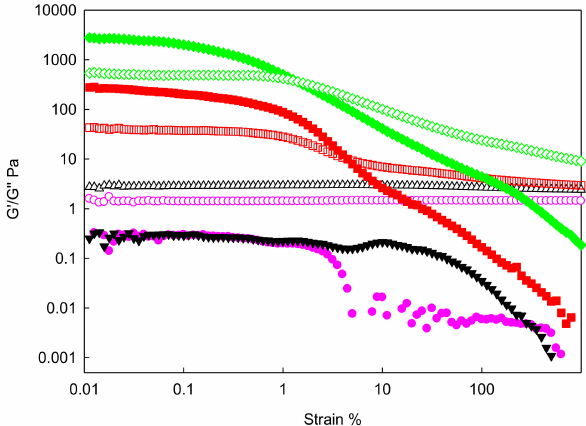
Figure 6. Store (G (cid:48) , solid symbols) and loss (G”, empty symbols) moduli versus strain for xGnP / [C 2 C 1 py][C 4 F 9 SO 3 ] at mass concentrations: (circle — ) 0 wt%; (triangle — ) 1 wt%; (square — ) 5 wt%; and (diamond — ) 10 wt% at 293.15